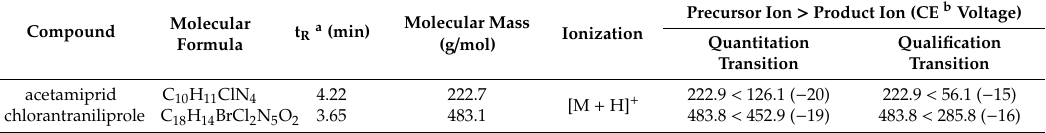
Table 1. Multiple reaction monitoring (MRM) parameters and retention times for the ultra-high performance liquid chromatography coupled with tandem mass spectrometry (UHPLC-MS / MS)